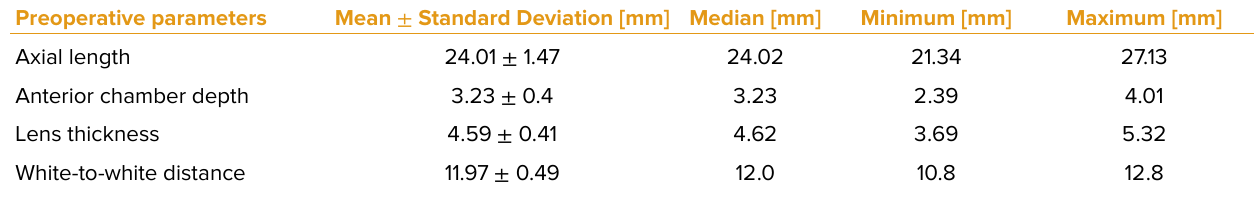
Table 1. Preoperative values of the relevant morphologic parameters in 40 consecutive eyes undergoing low-energy femtosecond-laser assisted cataract surgery Preoperative parameters